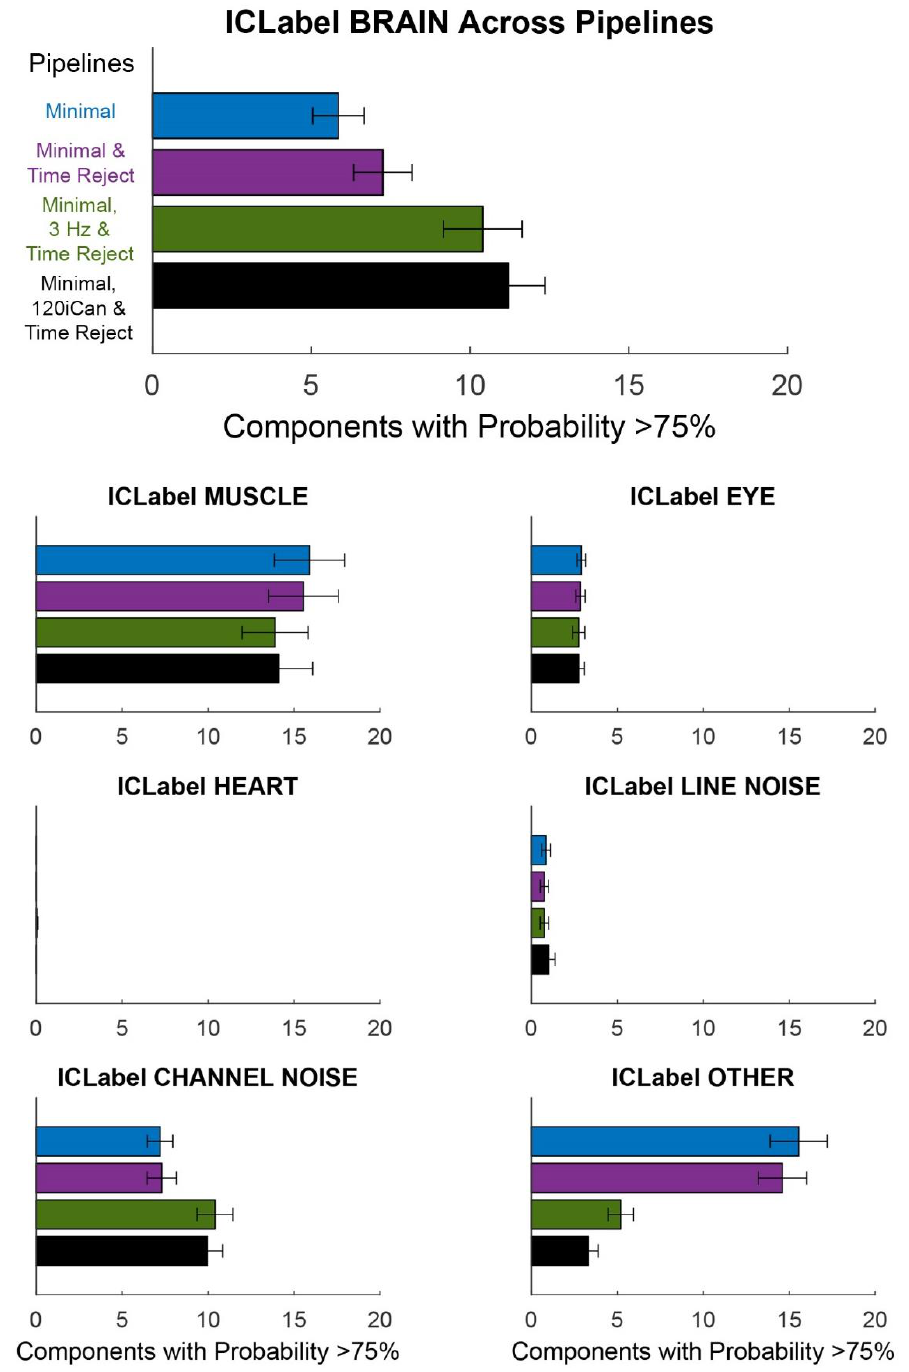
Figure 8. ICLabel classification of components for different pipelines. Each bar plot shows the mean +/− SEM of the number of components with classification probability >75% MUSCLE, EYE, HEART, LINE NOISE, CHANNEL NOISE, and OTHER. The Minimal pipeline (blue) includes basic prepro- cessing (filtering, channel rejection, interpolation, average re-referencing). The Minimal & Time Re- ject pipeline (purple) rejects bad time windows using clean_artifacts after minimal cleaning. The Minimal, 3 Hz, & Time Reject pipeline (green) filters the scalp channels after minimal cleaning and